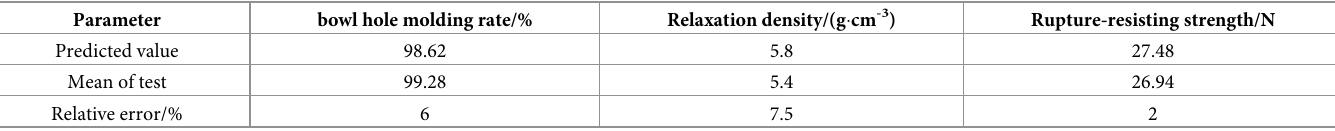
Table 5. Experiment data for test validation.